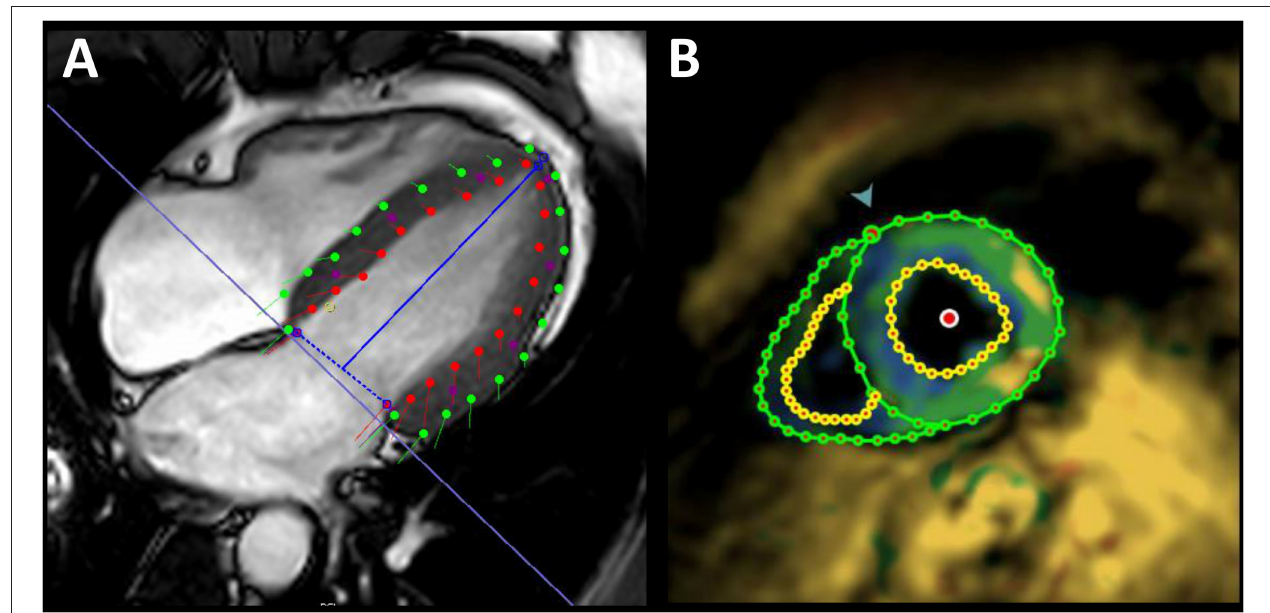
FIGURE 2 | Exemplary illustration of strain assessment. Global longitudinal strain assessment in a 32-year-old healthy male using feature tracking (A) and fSENC imaging (B) . Red/yellow points, endocardial contours; green points, epicardial contours; blue line, mitral valve insertion points and apex; green arrow, attachment of the right ventricular wall to the left ventricle for AHA